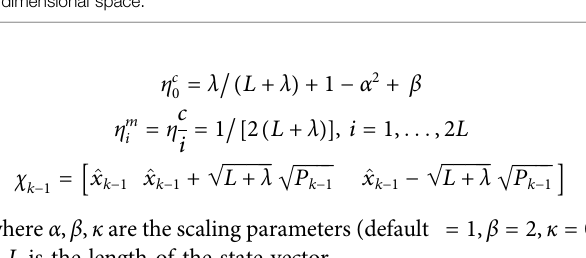
FIGURE 8 | Two kinds of distributions of point sets in two- dimensional space.